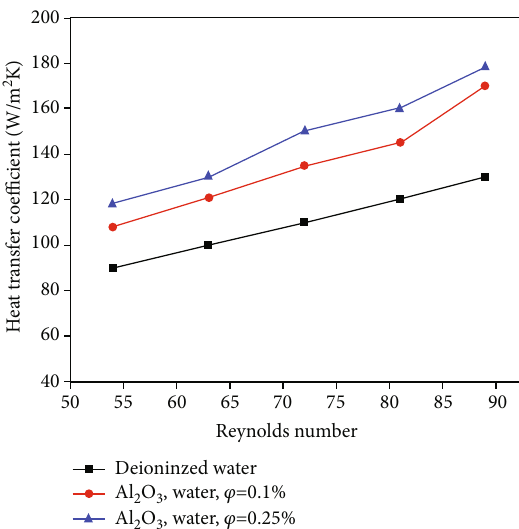
Figure 8: Heat transfer coe ffi cient vs. Reynolds number for heat input of 6W.